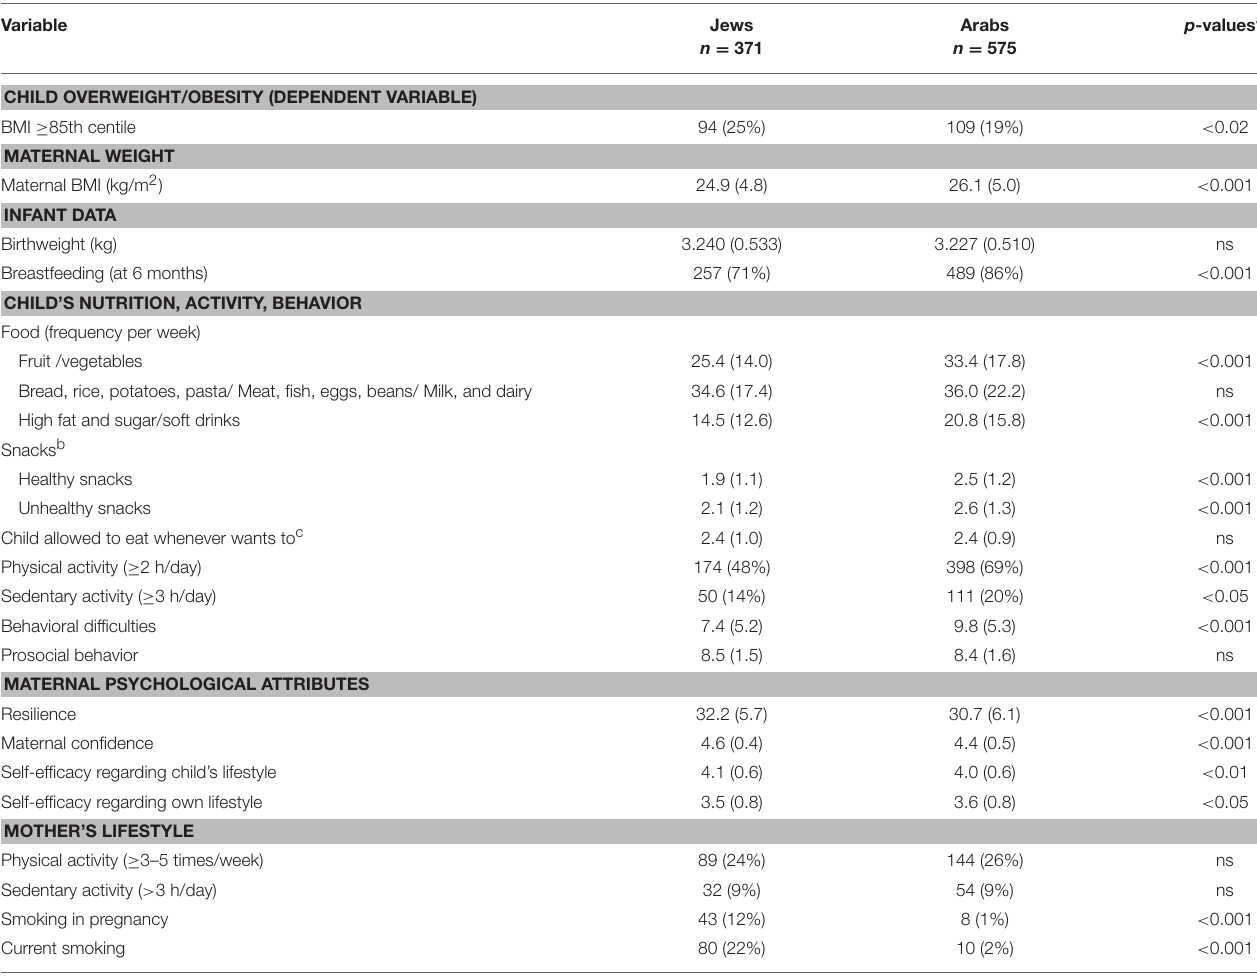
TABLE 2 | Comparison of the study variables in the Jewish and Arab groups.